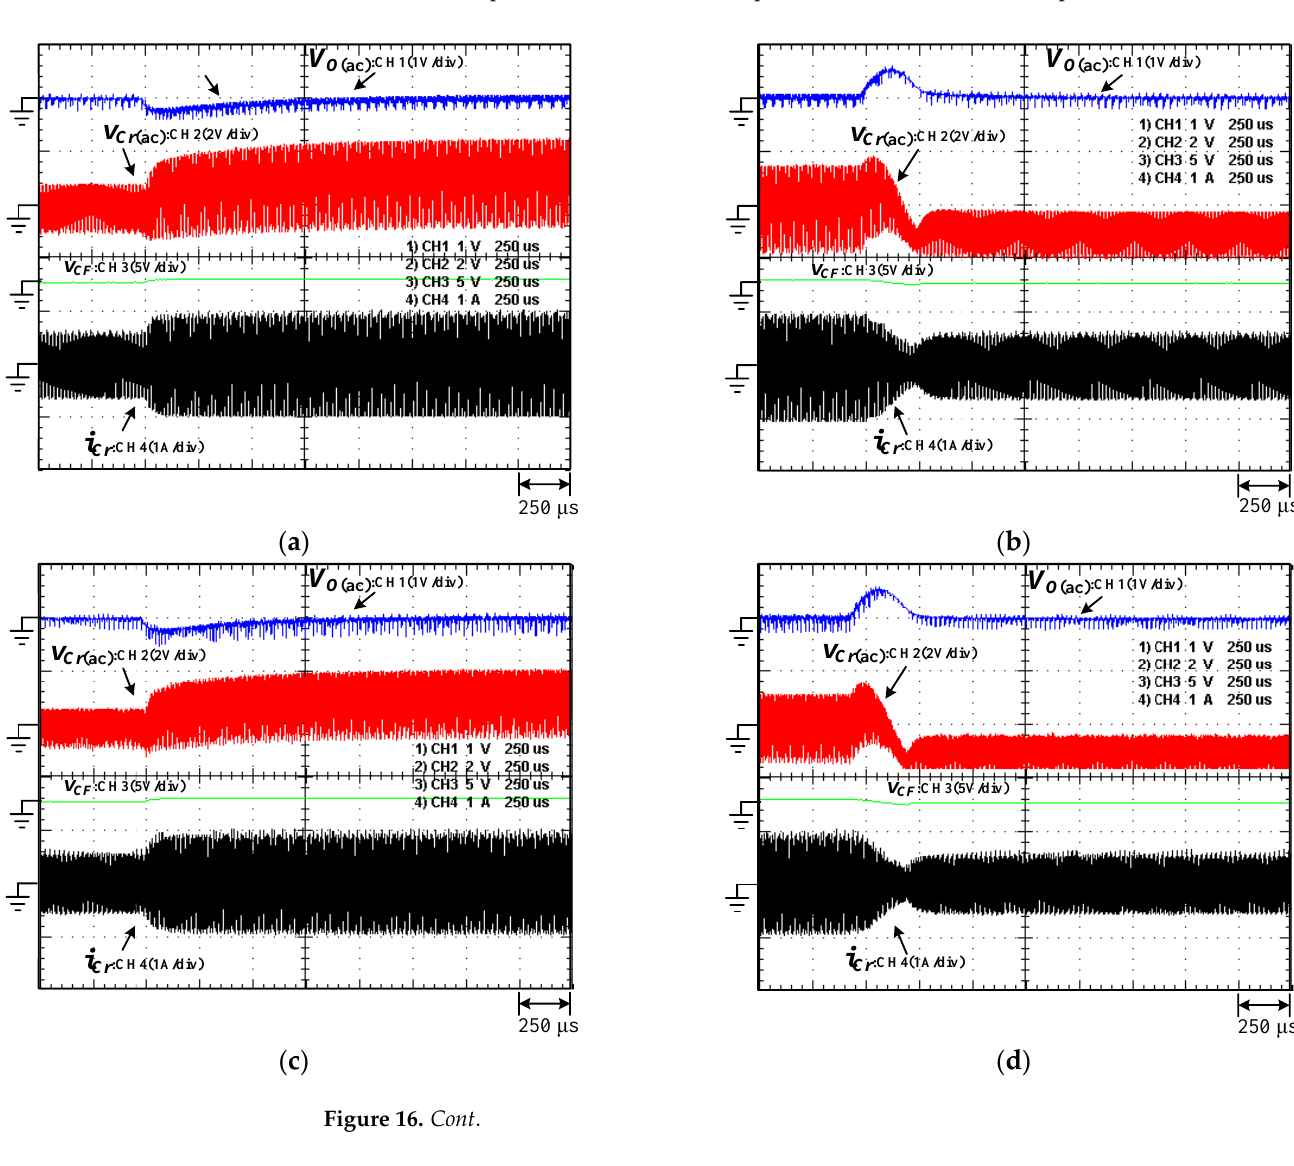
Figure 15. Measured curves of gain margin and phase margin under ( a ) 10% load at input 24 V; ( b ) full load at input 24 V; ( c ) 10% load at input 48 V; and ( d ) full load at input 48 V.